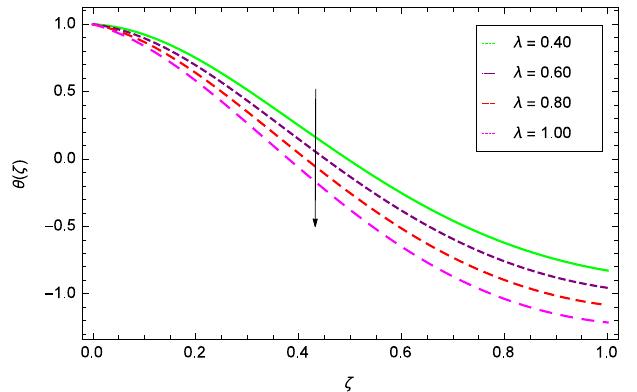
Figure 25. Parameter effect on heat transfer θ ( ζ ) profile.